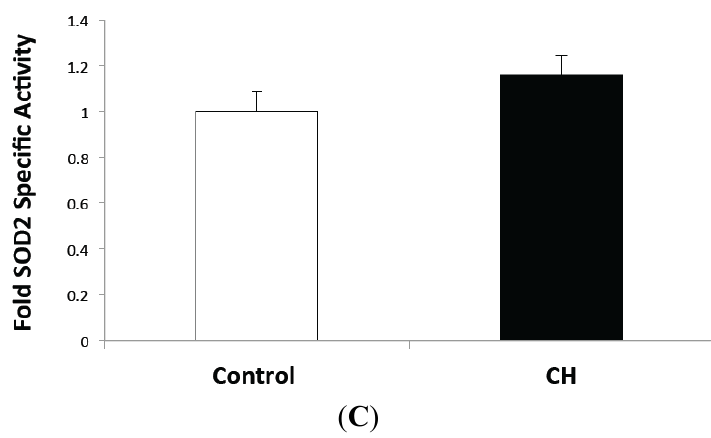
Figure 1. Chronic hyperoxia (CH) exposure increased SOD2 protein expression but not activity in mouse lungs. ( A ) Expression was measured in lung protein by Western blot in control and CH mice ( n = 12 per group, * p < 0.05 vs. control); ( B ) Representative Western blot of SOD2 expression is shown with corresponding β-actin; and ( C ) SOD2 enzymatic activity was measured with a commercially available activity assay in control and CH mice ( n = 20 per group). Data are shown as fold mean ±